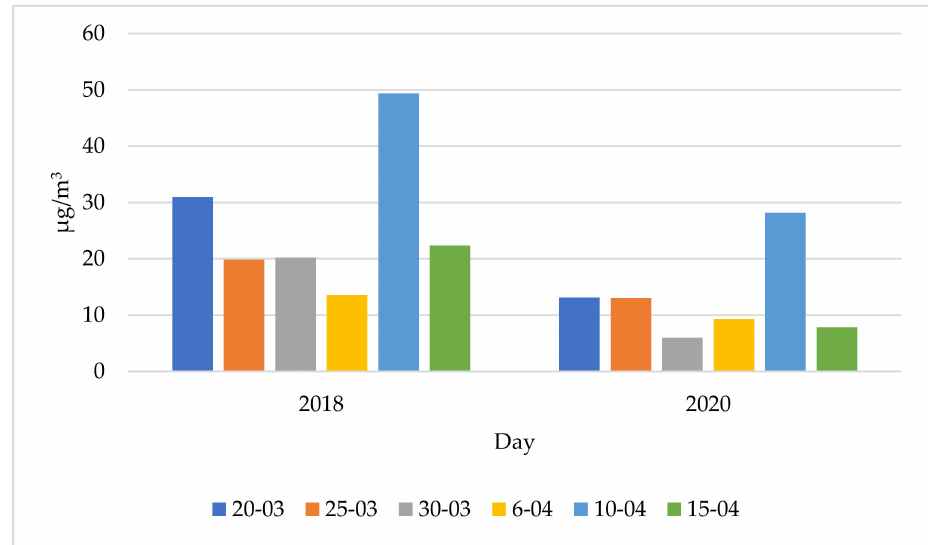
Figure 9. NO 2 concentration in Warsaw on individual days of 2018 and 2020. Source: Own elaboration, based on data from Copernicus Atmosphere Monitoring Service (CAMS) [47].